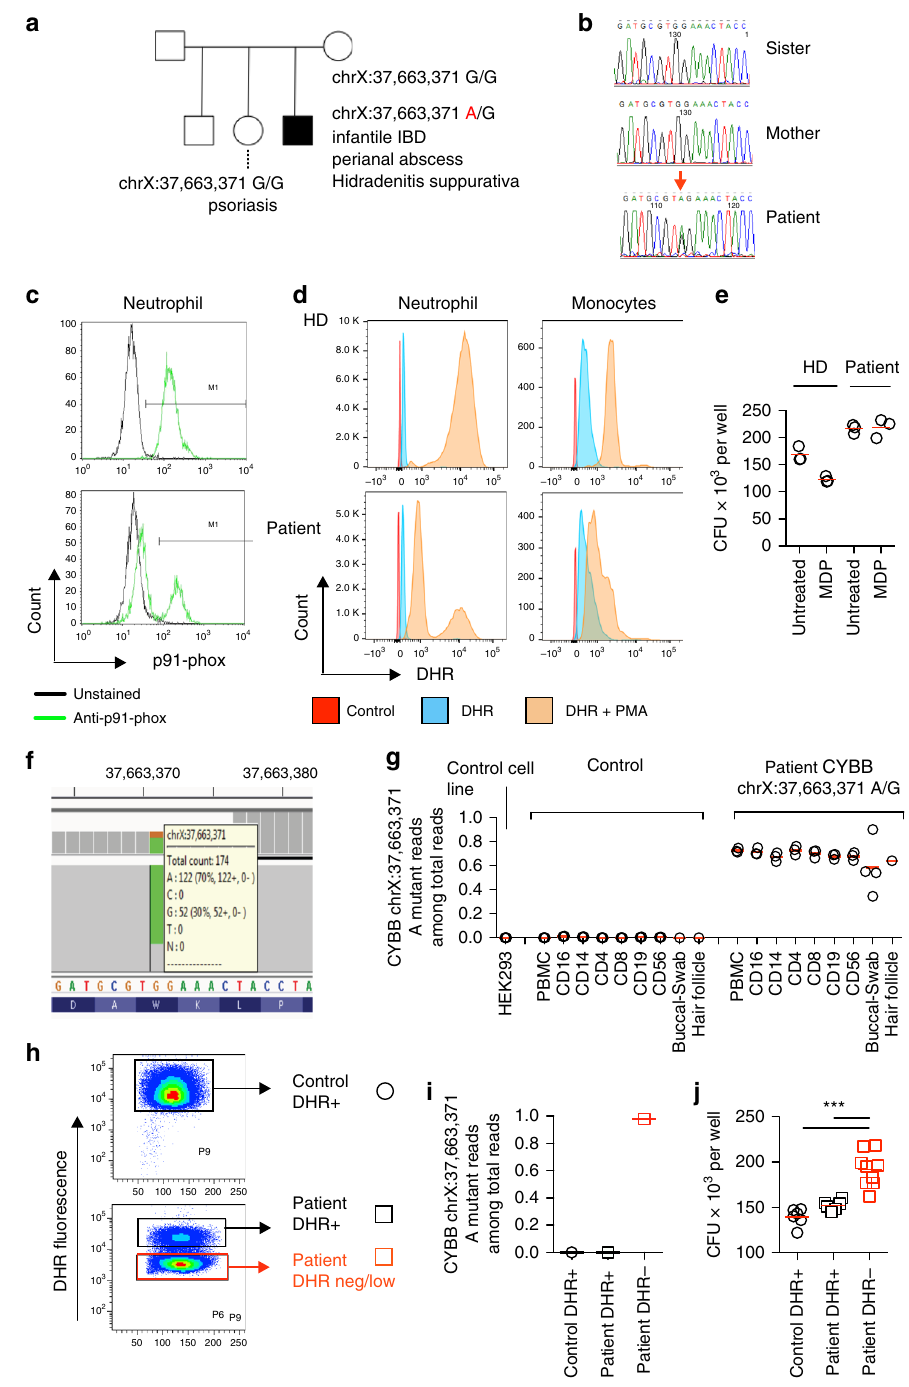
validation experiments con fi rmed the mosaicism, with 70% of neutrophils and monocytes showing completely absent NADPH- oxidase activity as seen in CGD patients, and 30% of cells showing a normal pro fi le (Fig. 1d, see Methods section). This degree of mosaicism affected bacterial handling capacity since monocyte- derived macrophages from the patient had ~30% more colonies at baseline but did not respond to muramyl dipeptide (MDP) in the gentamicin protection assay (Fig. 1e; see Methods section), a fi nding suggestive of a bacterial handling defect 31 . Our results suggest that the proportion of cells with complete loss-of-function of CYBB affects the phenotypic presentation, i.e., 30% wild-type